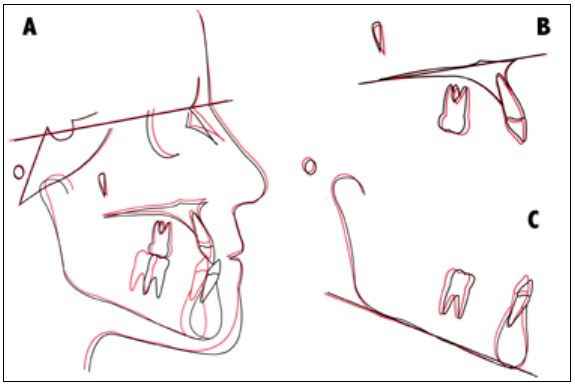
Figure 13. Superimposed pretreatment (black line), post-treatment (red line) cephalometric tracings. (A) Superimposed on the Sella-Nasion plane at Sella. (B) Superimposed on the palatal plane at Anterior Nasal Spine. (C) Superimposed on the mandibular plane at